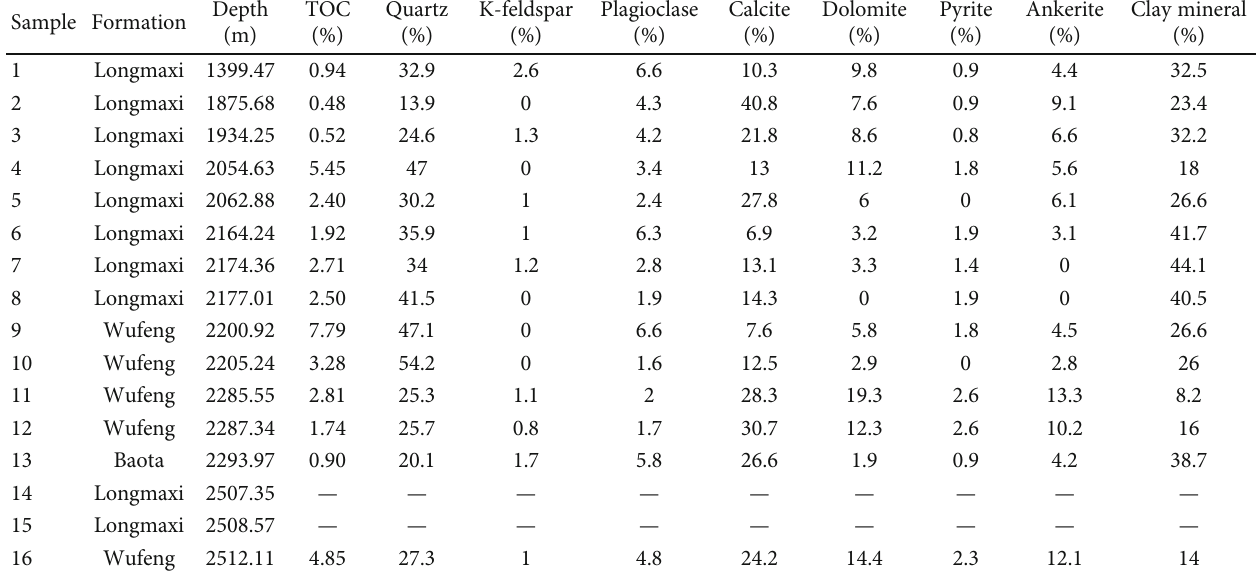
Table 1: Shale mineral composition characteristics of Wufeng-Longmaxi formation. Sample